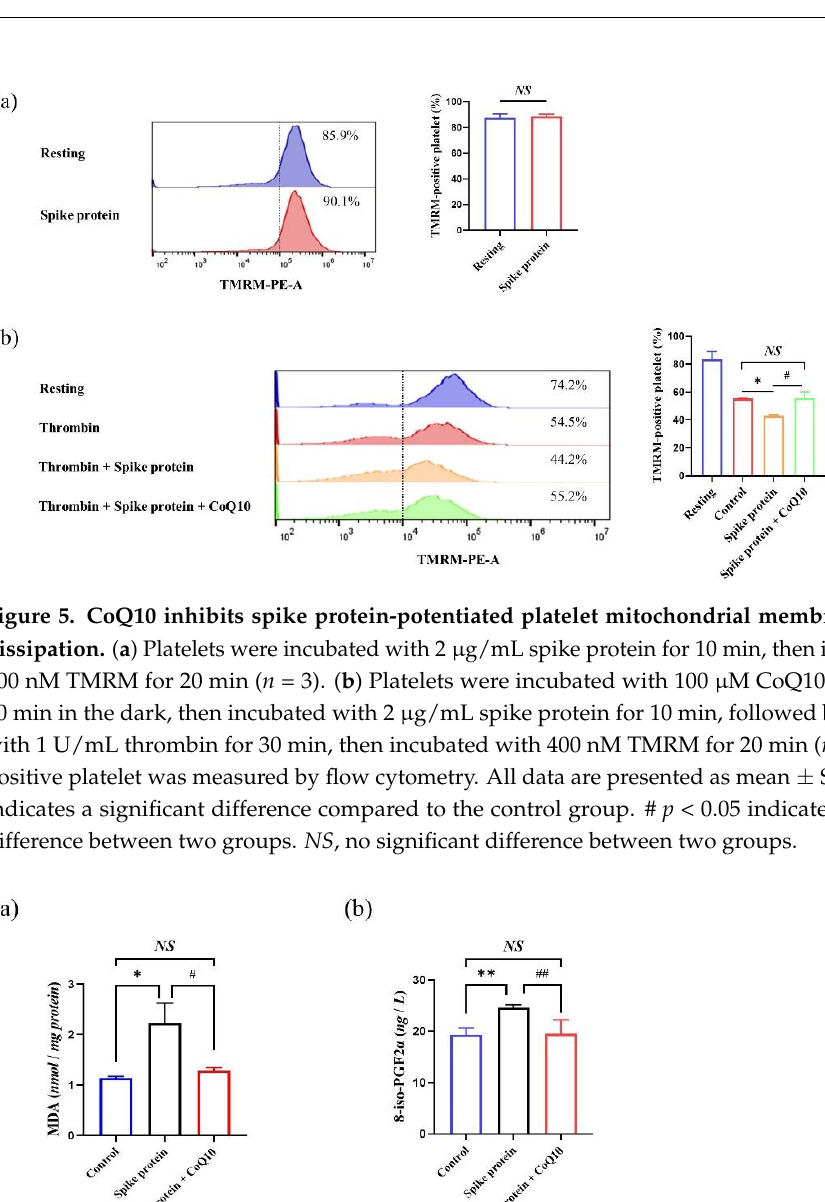
Figure 7. CoQ10 improves platelet antioxidative activity reduced by spike protein. Gel-filtered platelets were incubated with CoQ10 or solvent for 50 min, then incubated with spike protein for 10 min, then stimulated with thrombin for 10 min. ( a ) Platelets lysates were used for SOD activity anal- ysis ( n = 4). ( b ) Platelets lysates were used for T-AOC level measurement ( n = 5). All data are